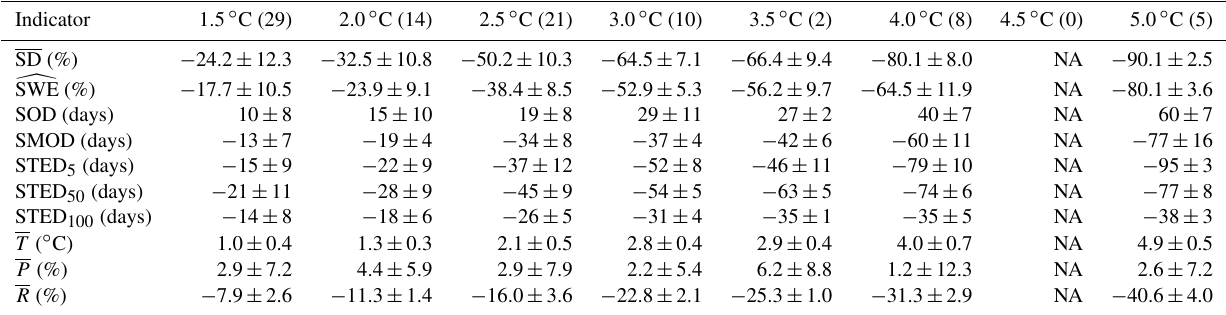
Table 6. Mean value ± standard deviation of the changes in each indicator between ALL and the reference period (1986–2005), for (cid:49)T g , EOC − PI intervals of 0.5 ◦ C. The number of values used in each interval is indicated inside brackets. NA – not available